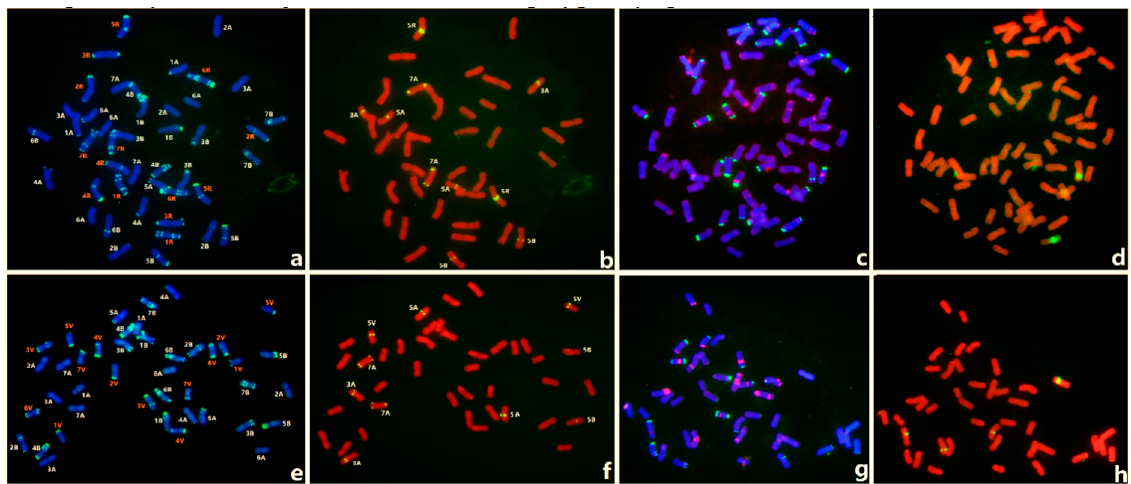
Figure 6. ND-FISH on chromosomes of hexaploid triticale ( a , b ), Thinopyrum ponticum ( c , d ), T. durum–Dasypyrum villosum amphiploid ( e , f ), and Th. intermedium ( g , h ). The probes Oligo-pSc119.2 and pTa535 ( a , c , e , g ) and sequential Oligo-3A1 ( b , d , f , h ) were used, respectively.